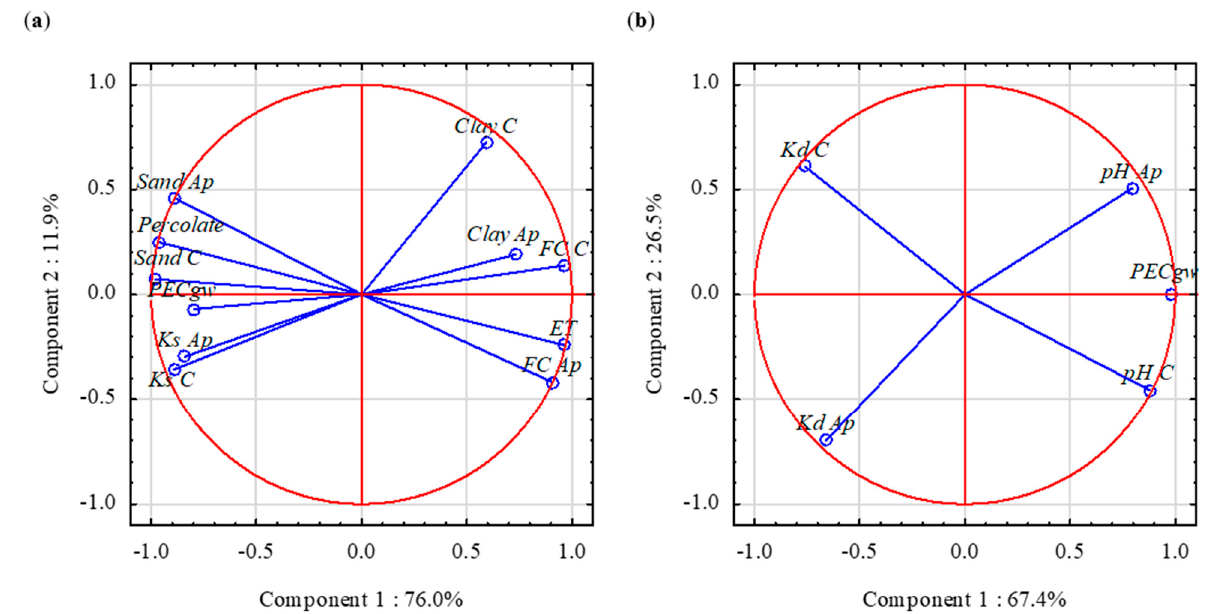
Figure 2. PCA results: ( a ) The effect of soil properties on PEC gw in the AR, LV, and LV&CM soil groups in SM2 simulations of potato cultivation; ( b ) The effect of soil properties on PEC gw in the AR soil group in SM2 simulations of potato cultivation.